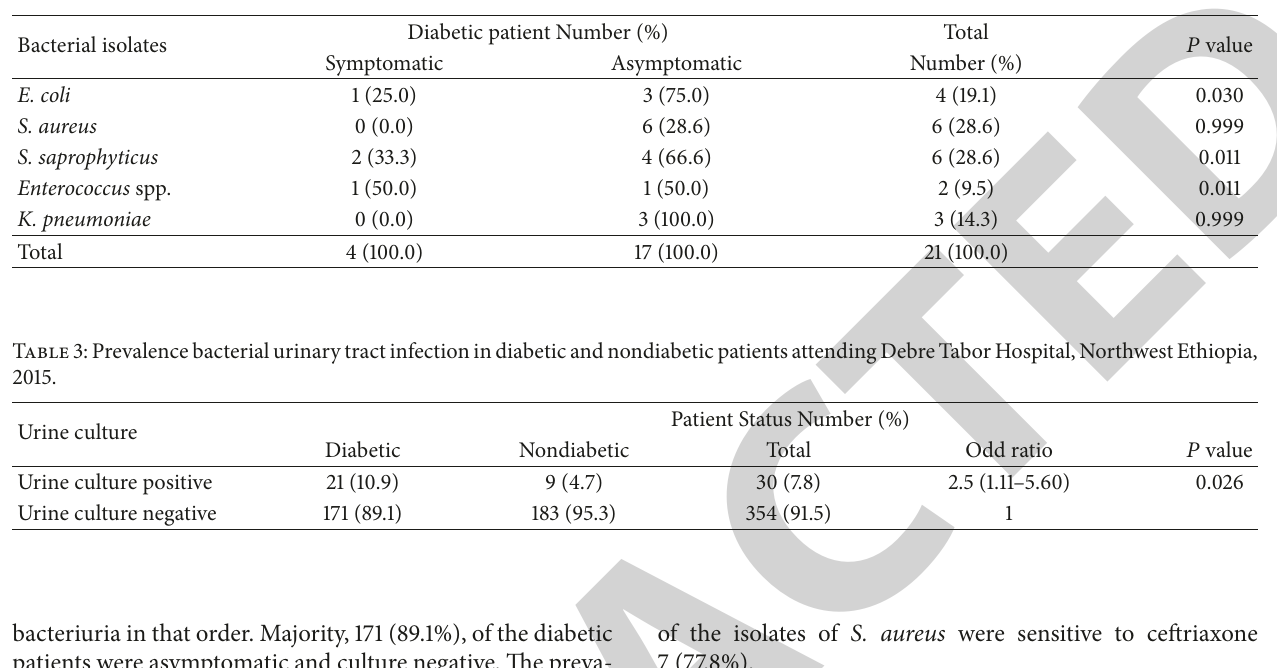
Table 2: Frequency and types of bacterial species isolated from symptomatic and asymptomatic diabetic patients’ urine culture attending Debre Tabor Hospital, Northwest Ethiopia, 2015.